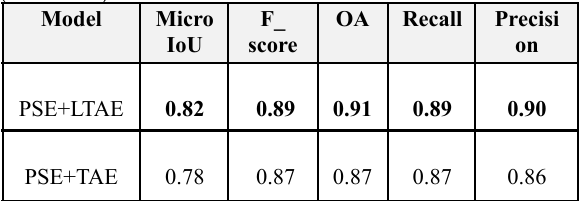
Table 6. Results of pre-trained models (PSE+LTAE)